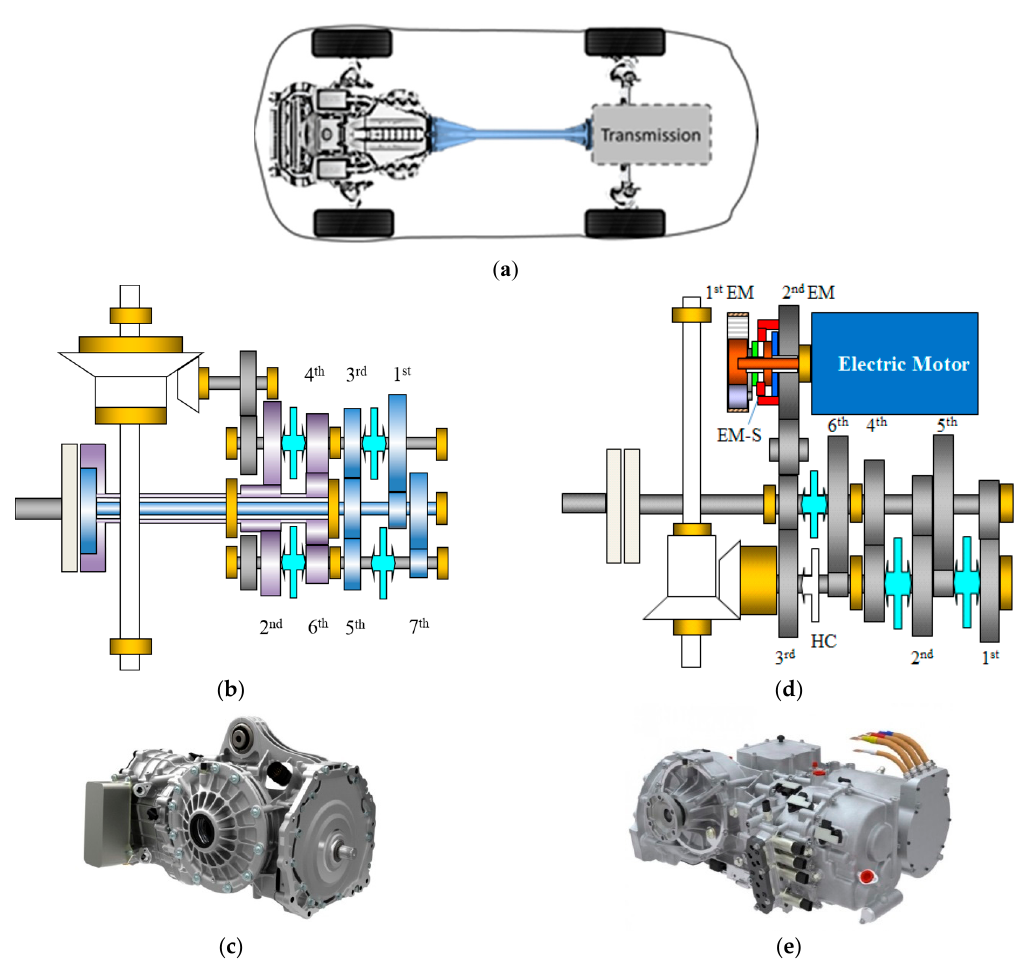
Figure 1. ( a ) Case study vehicle configuration; ( b ) DCT layout; ( c ) 3D model of the DCT; ( d ) HAMT layout; ( e ) 3D model of the HAMT.